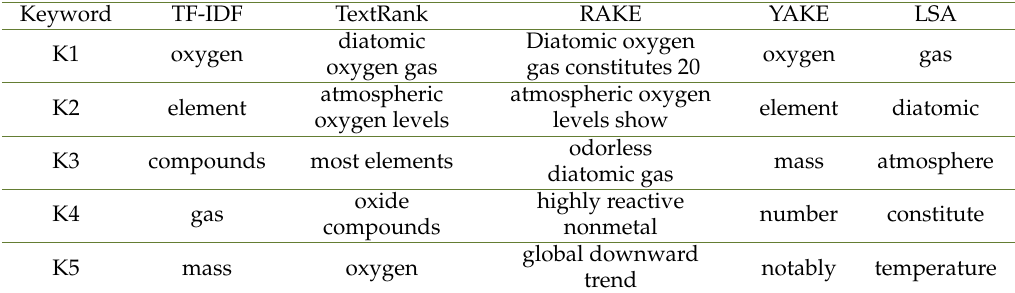
Table 3. Implementation of different